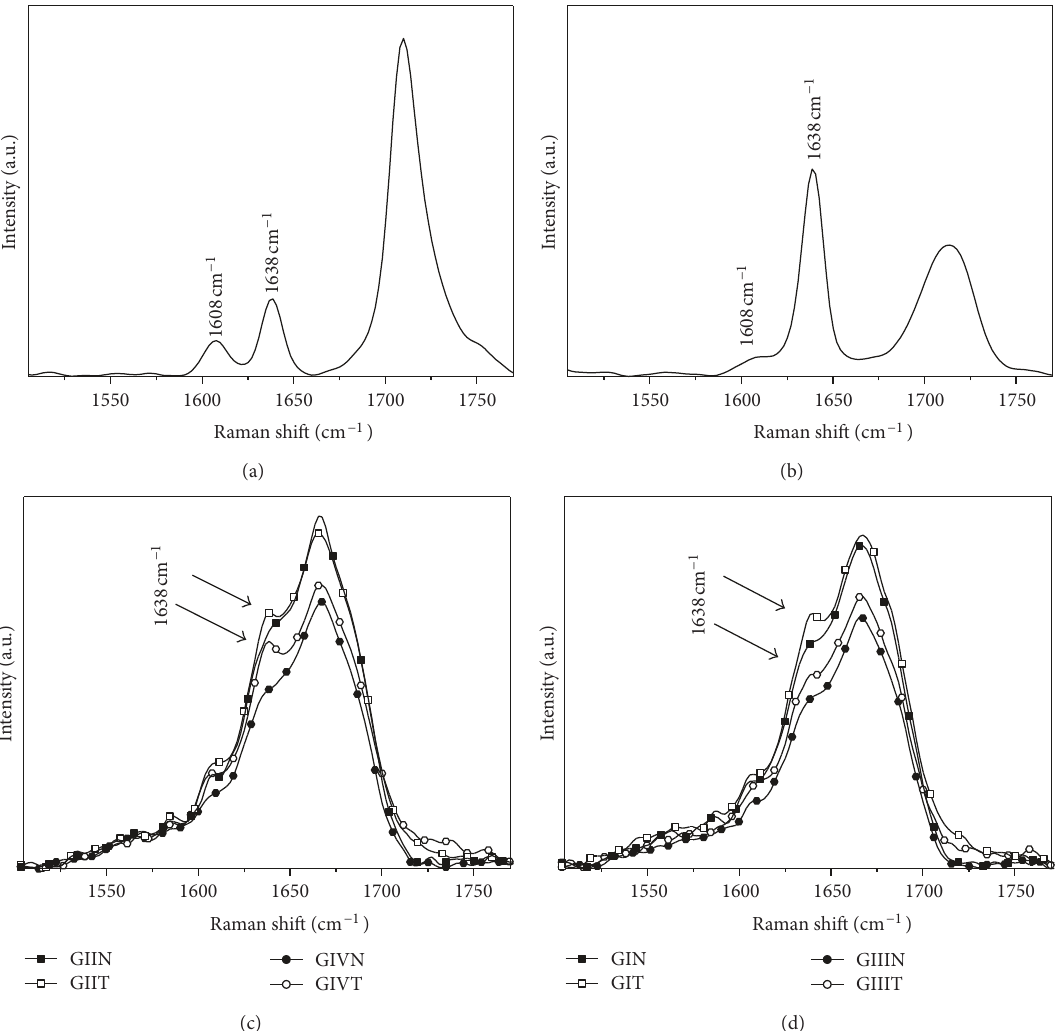
F 3: FT-Raman spectra of Prime & Bond 2.1 (a) and Xeno III adhesives (b); dentin treated with Prime & Bond 2.1 (c) and Xeno III (d)